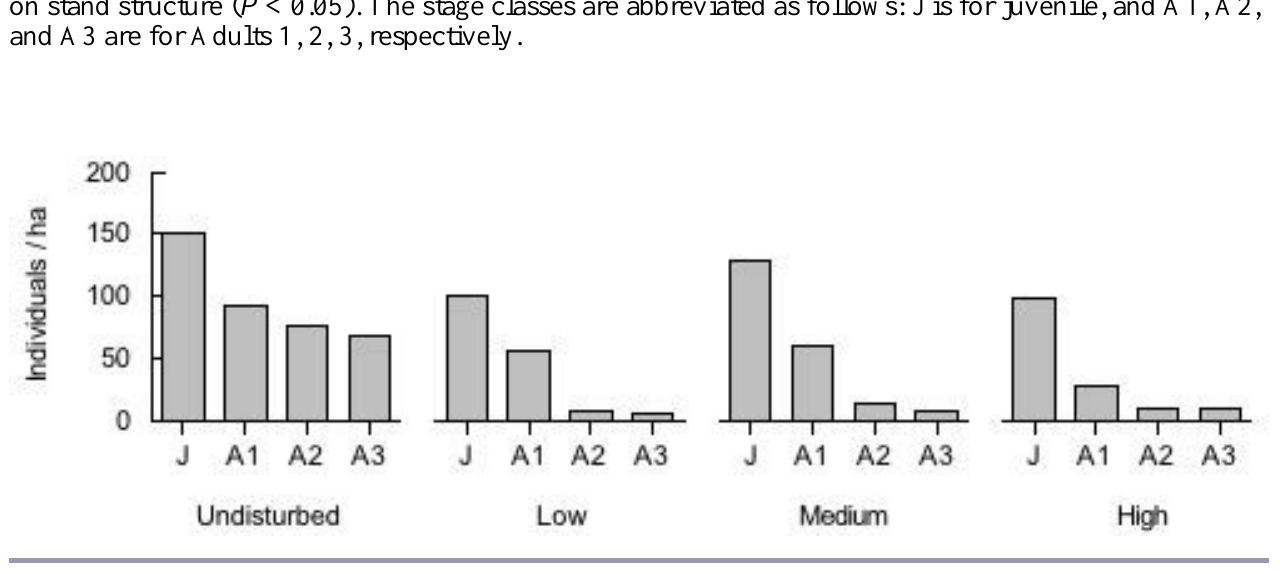
Fig. 5. Comparison of the size structure of the undisturbed population with the average structures of the stands at Low, Medium, and High harvesting intensities. Harvesting had a statistically significant effect on stand structure ( P < 0.05). The stage classes are abbreviated as follows: J is for juvenile, and A1, A2, and A3 are for Adults 1, 2, 3,